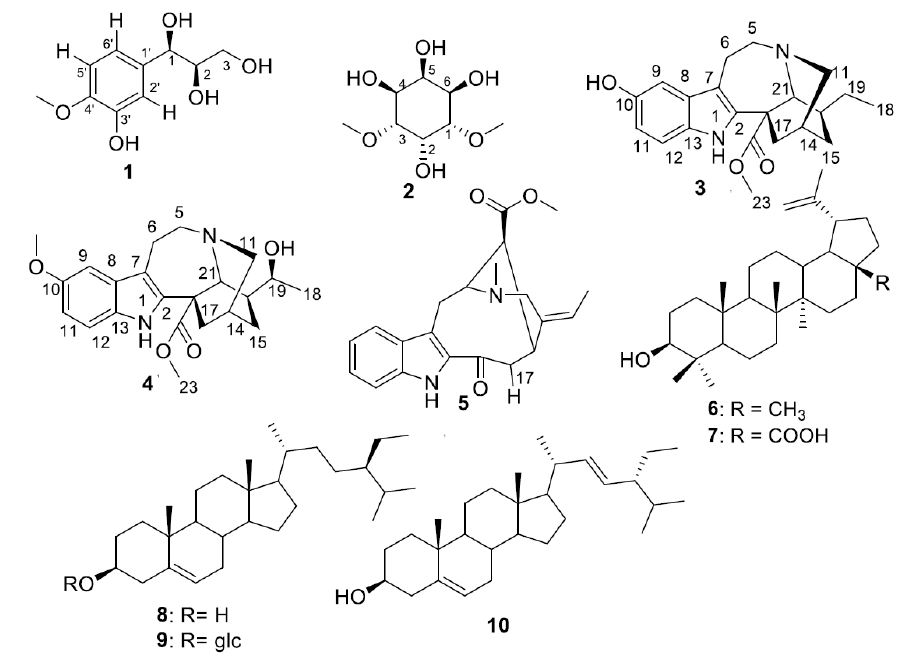
Figure 3. Chemical structures of compounds 1 – 10 from T. inconspicua .